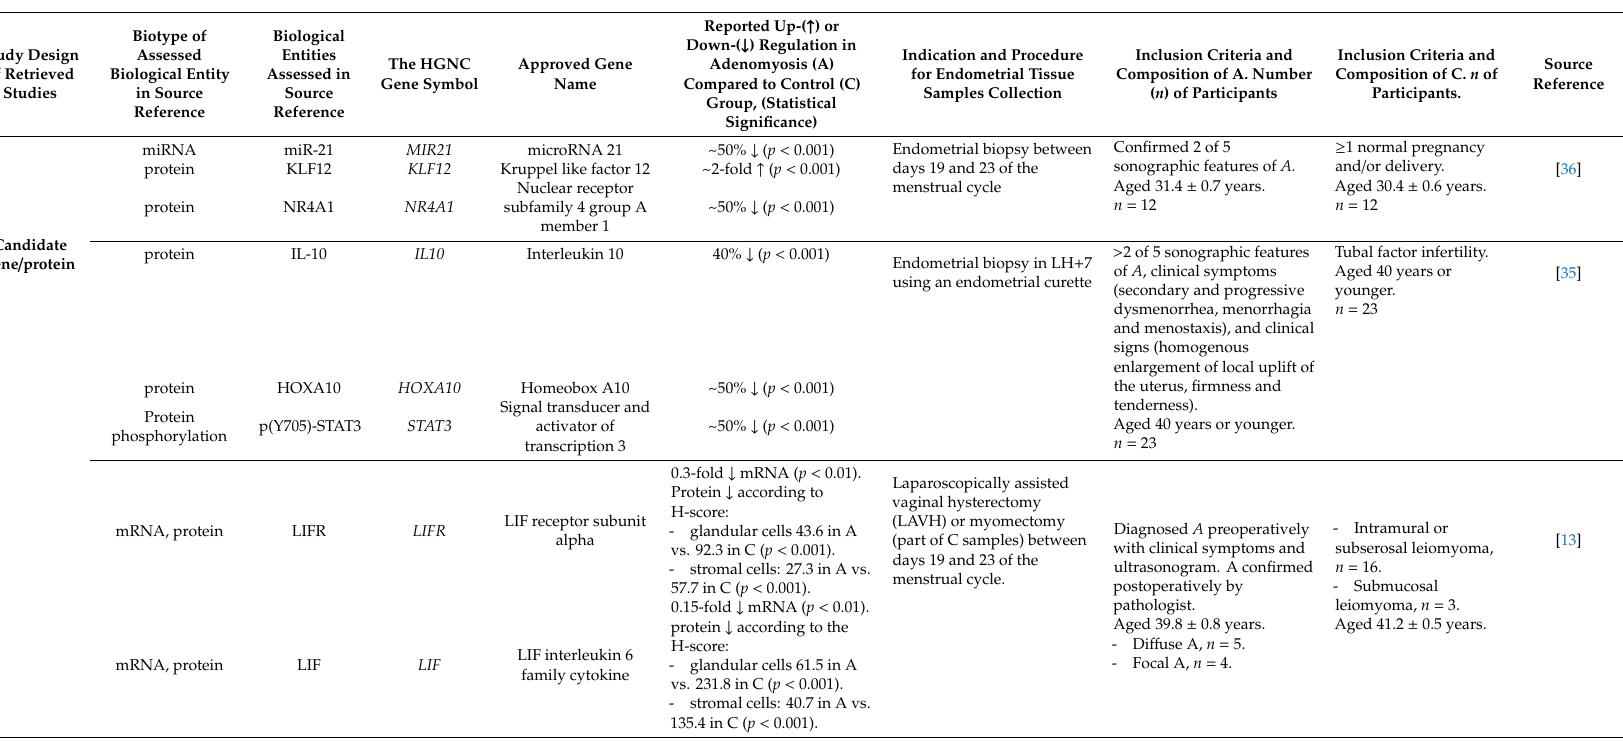
Table 1. Retrieved studies reporting altered expression levels of transcripts / proteins in endometrial samples during frame of receptivity in women with adenomyosis. Nomenclature (gene symbol and approved gene name) of extracted data was edited according to the HUGO Gene Nomenclature Committee (HGNC) database. Letters A and C refer to adenomyosis and control women / group, respectively. Symbols ↑ and ↓ refer to reported up- and down-regulated, respectively, expression level of genes and proteins when compared adenomyosis with the control group in the source